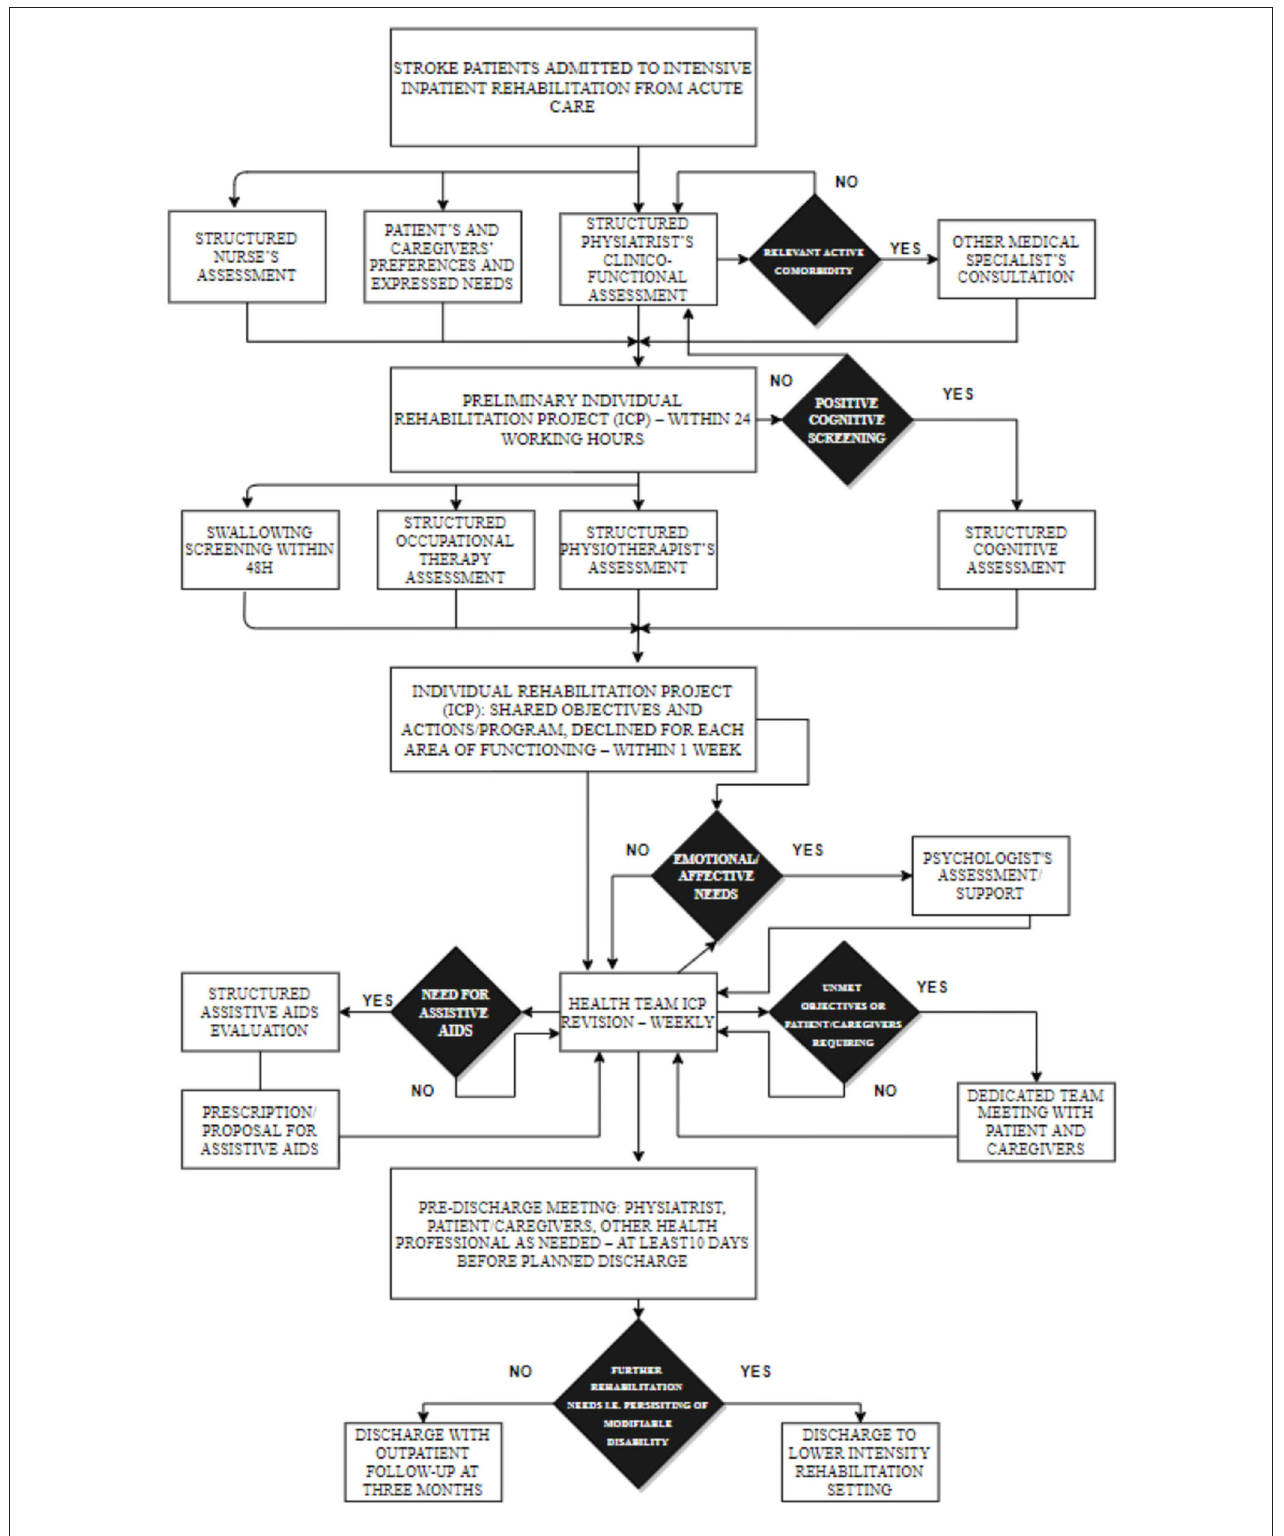
FIGURE 2 | Rehabilitation